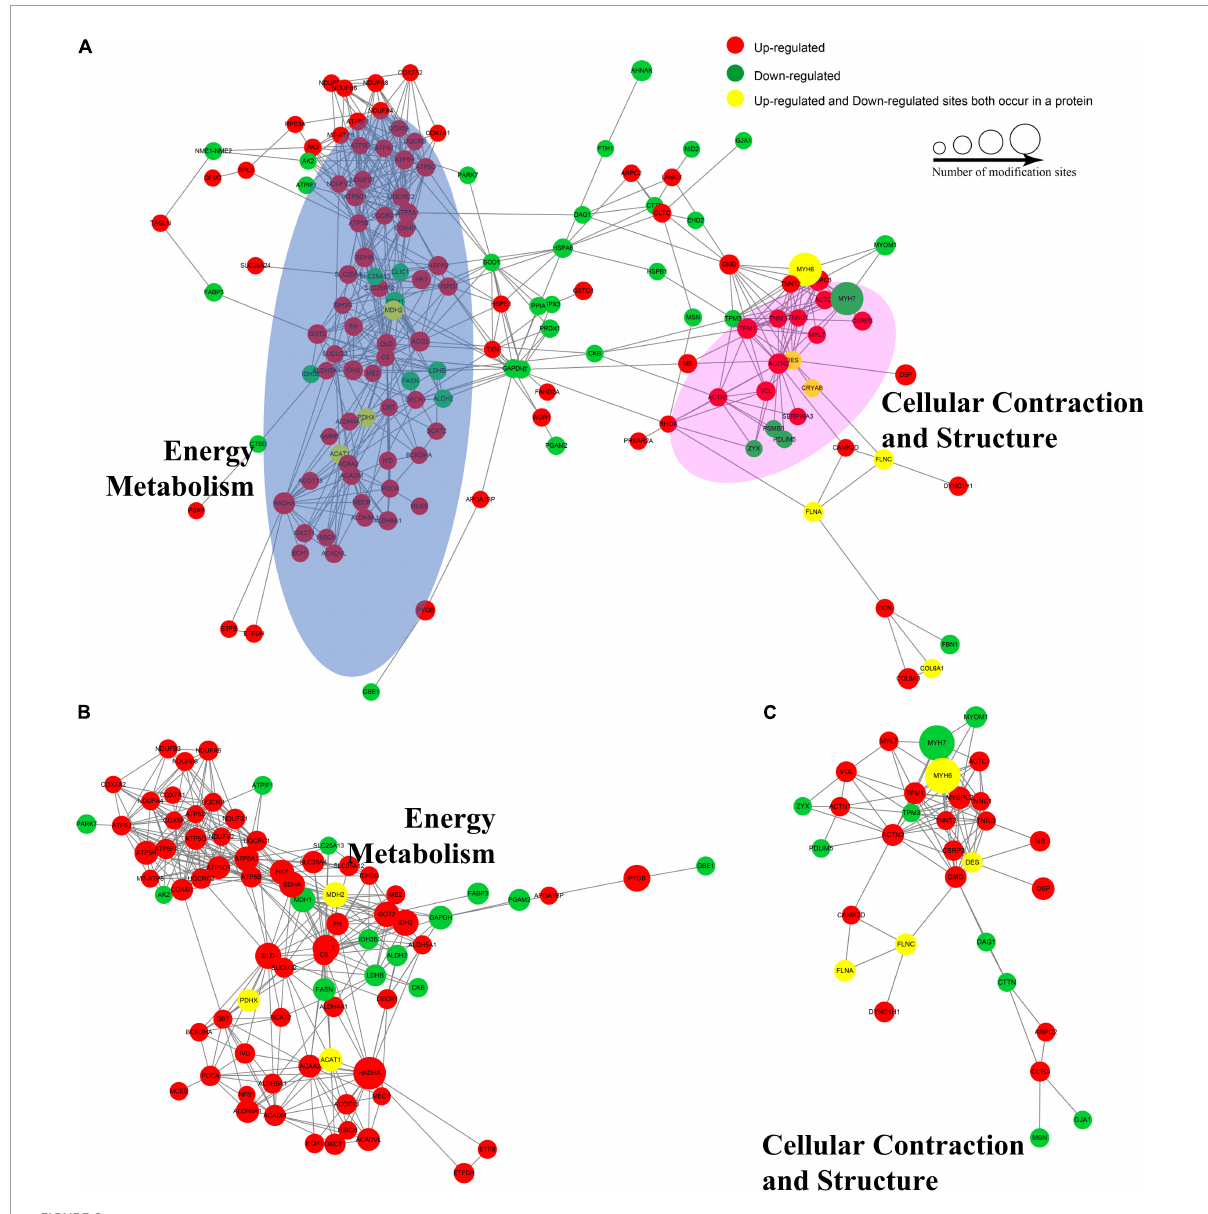
FIGURE6 Protein–protein interaction networks of the AF/SR differentially expressed acetylated proteome in LAA tissues. (A) Protein–protein interaction networks of the total AF/SR differentially expressed Kac proteins. The blue oval area in panel (A) represents the position occupied by most of the Kac proteins related to energy metabolism in the interaction networks, and the pink area represents the cellular contraction- and structure-related Kac proteins. (B) Protein–protein interaction networks of the AF/SR differentially expressed Kac proteins related to energy metabolism. (C) Protein–protein interaction networks of the AF/SR differentially expressed Kac proteins related to cellular contraction and structure. AF, atrial fibrillation; SR, sinus rhythm; LAA, left atrial appendage.